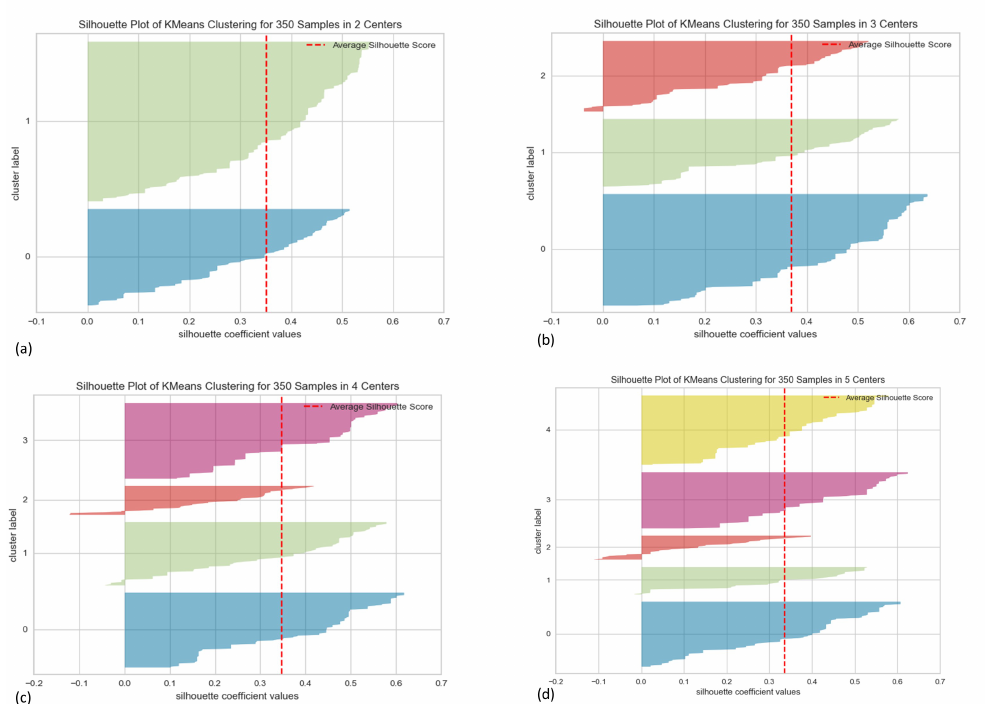
Figure 6. The different number of clusters using the silhouette method over eudaimonic and hedonic variables. ( a ): k = 2, ( b ): k = 3, ( c ): k = 4 and ( d ): k = 5. Parameter k determines the number of clusters. The average value of the Silhouette coefficients is shown with a red dashed